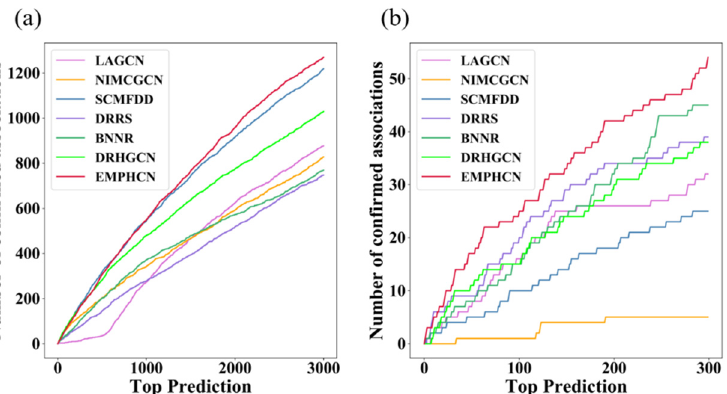
Figure 9. Comparison of novel prediction results with different methods. ( a ) Comparison of the number of successfully recovered positive samples on dataset T1. ( b ) Comparison of the number of successfully recovered positive samples on dataset T2.